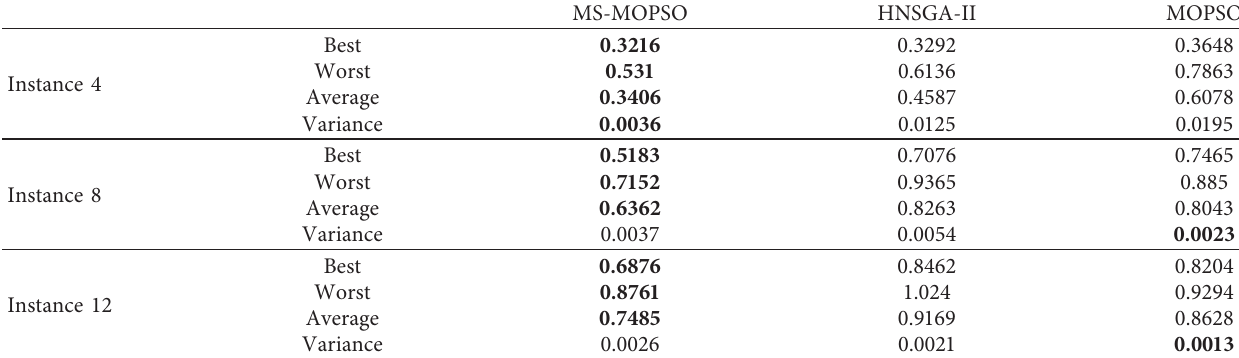
Table 7: Results of SM for three instances.